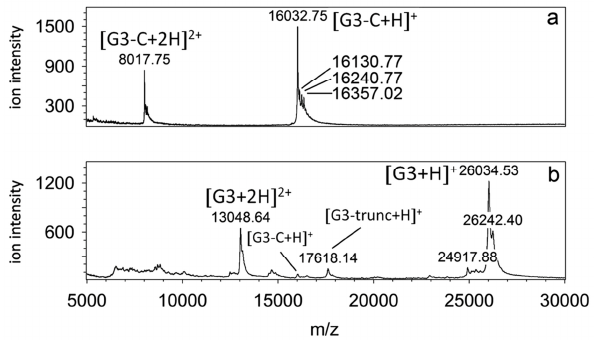
Figure 4. MALDI-TOF maps of galectin-3 samples. ( a ) MALDI-TOF map of the galectin-3C sample; ( b ) MALDI-TOF map of the galectin-3 sample. Reproduced with permission from [44]. Copyright John Wiley & Sons, Inc., 2017.